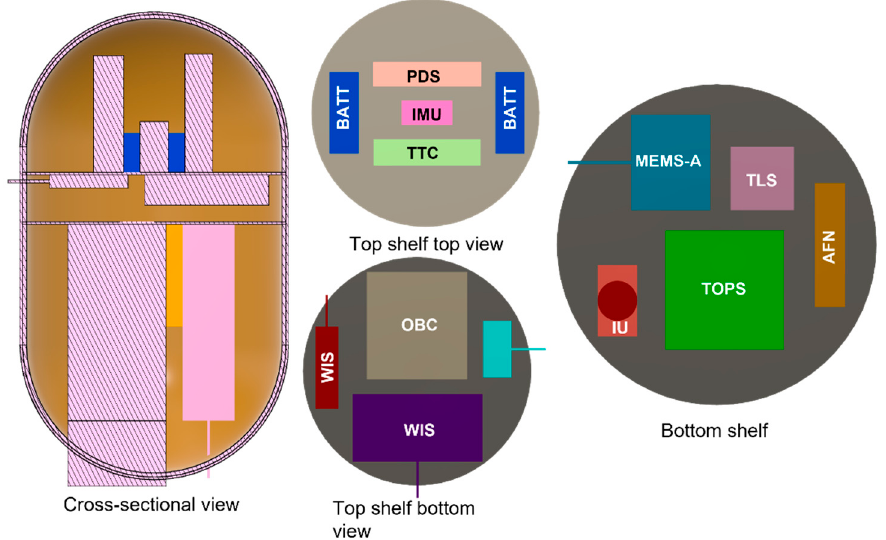
Figure 10. A notional schematic of the gondola with the instruments and subsystems mounted on two shelves. See Table 1 for the list of science instruments. For a detailed discussion of the instruments and science behind the proposed habitability mission architecture, see the VLF mission study report [10]. The subsystems are—BATT: Battery; TTC: Telemetry, Tracking, and